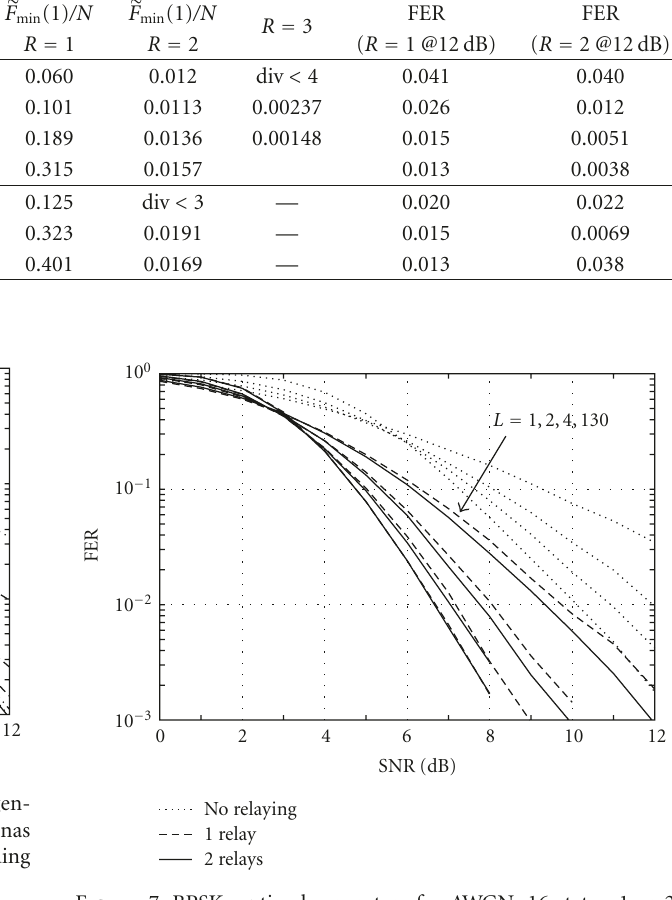
Figure 7: BPSK, optimal generators for AWGN, 16 states, 1 or 2 relays with P coop = 1,2 transmitting antennas per node, 1 receiving antenna, in BFC with various L